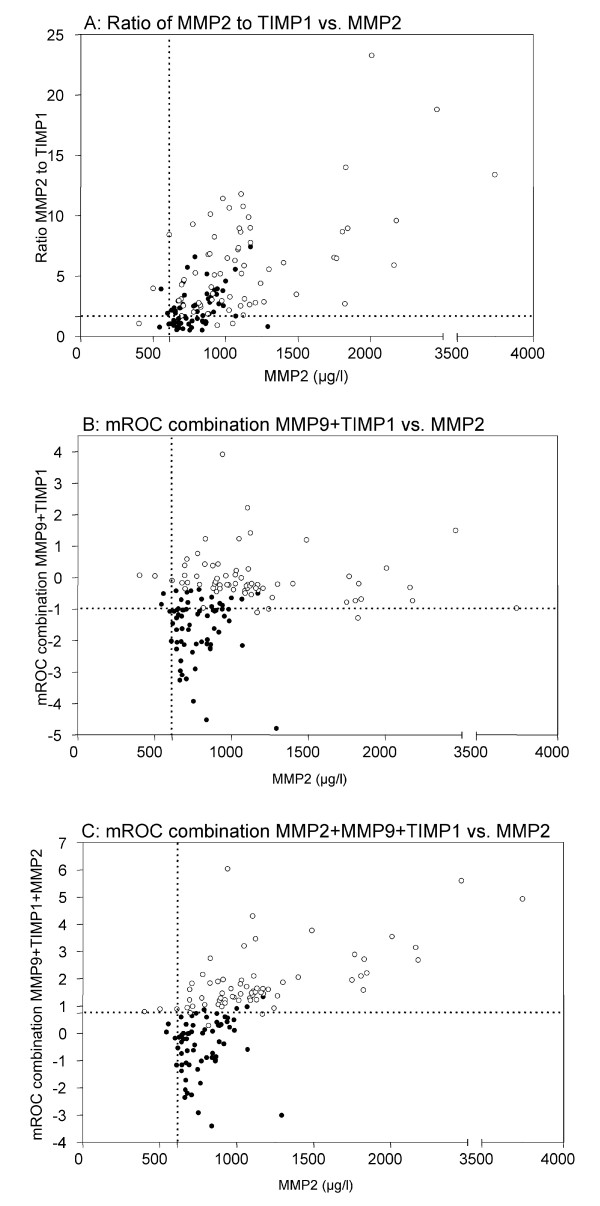
Dot-plots for presentation of the best marker combinations to distinguish between healthy persons (black dots) and bladder cancer patients (open dots). A: Ratio of MMP2 to TIMP1 versus MMP2; B: mROC combination of MMP9+TIMP1 versus MMP2; C: mROC combination of MMP2+MMP9+TIMP1 versus MMP2. The dashed lines indicate the cutoff values for 95% sensitivity of MMP2 and the corresponding marker combinations.